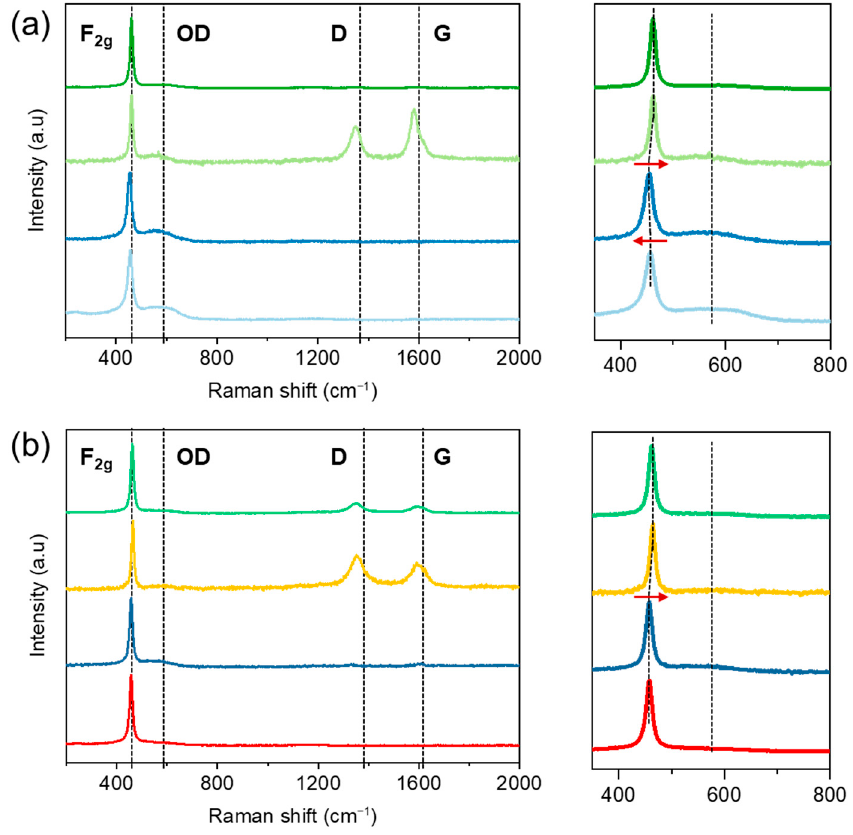
Figure 9. In-situ Raman spectroscopy study result of ( a ) Ni/CeO 2 -M catalysts, and ( b ) Ni/CeO 2 -C catalysts.